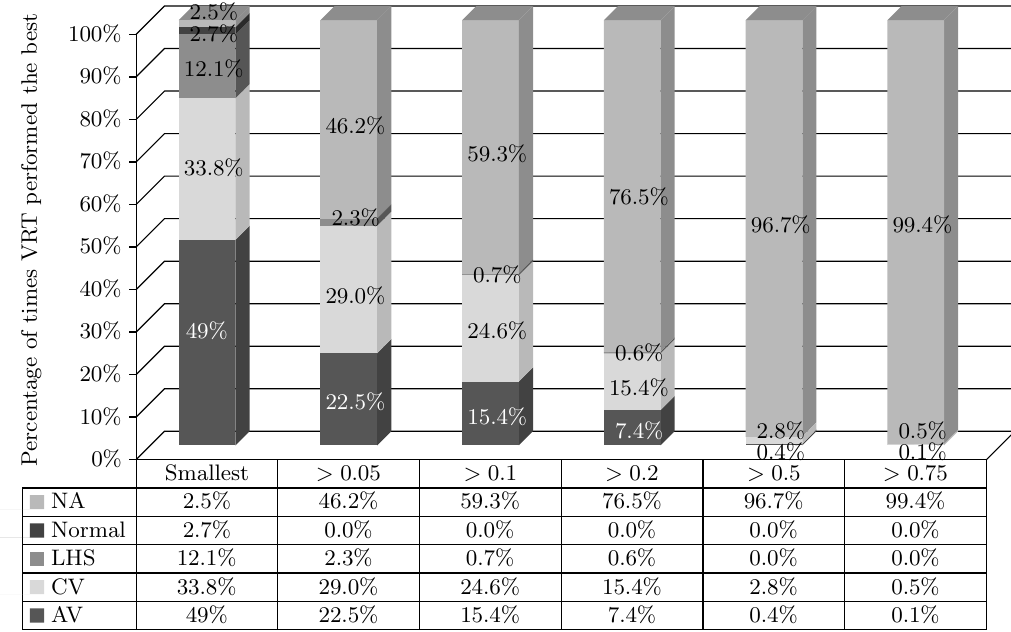
Figure 2: Graphical representation of comparison of VRTs over 1 620 problem